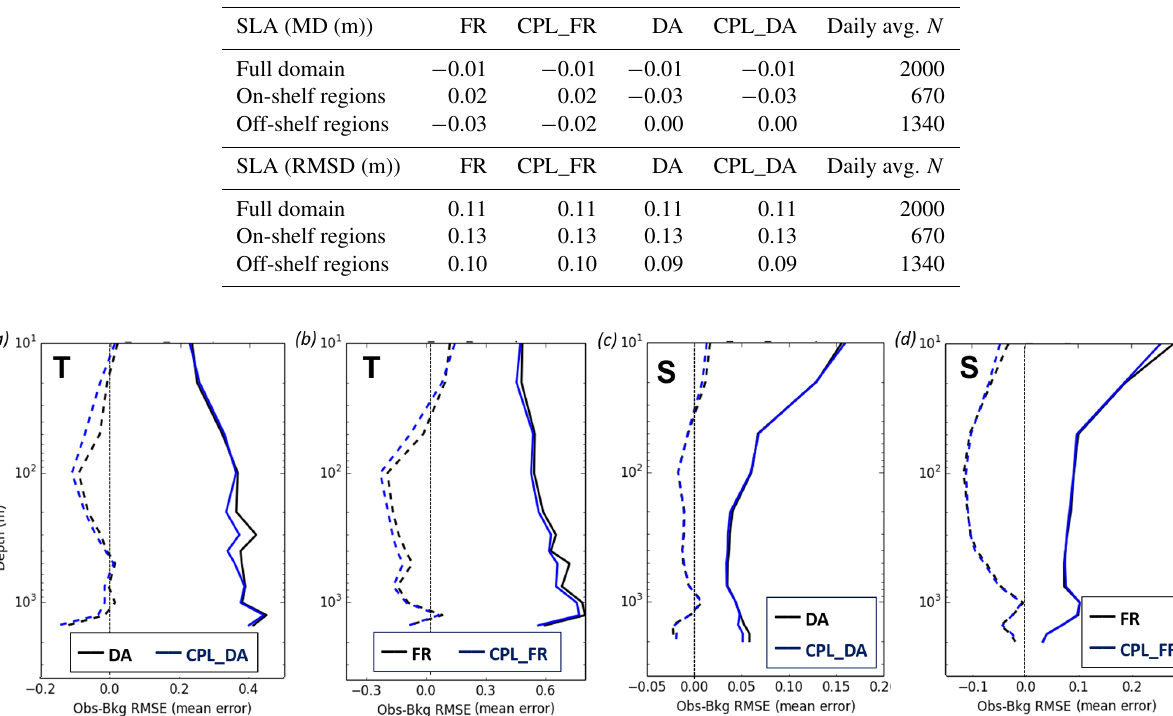
Figure 2. Vertical profiles of (dashed lines) Observation minus Model differences and (solid lines) RMSD statistics for ocean-only and coupled simulations, computed over 2-year simulation period (2016–2017) for (a, b) temperature and (c, d) salinity, comparing runs (a, c) with and (b, d) without